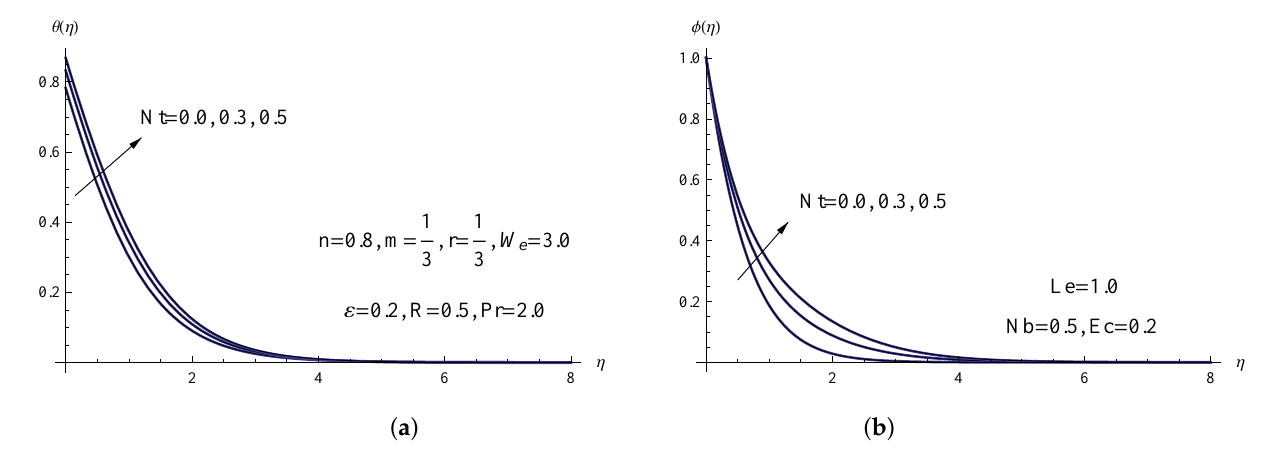
Figure 7. ( a ) θ ( η ) via Nt ; ( b ) φ ( η ) via Nt .